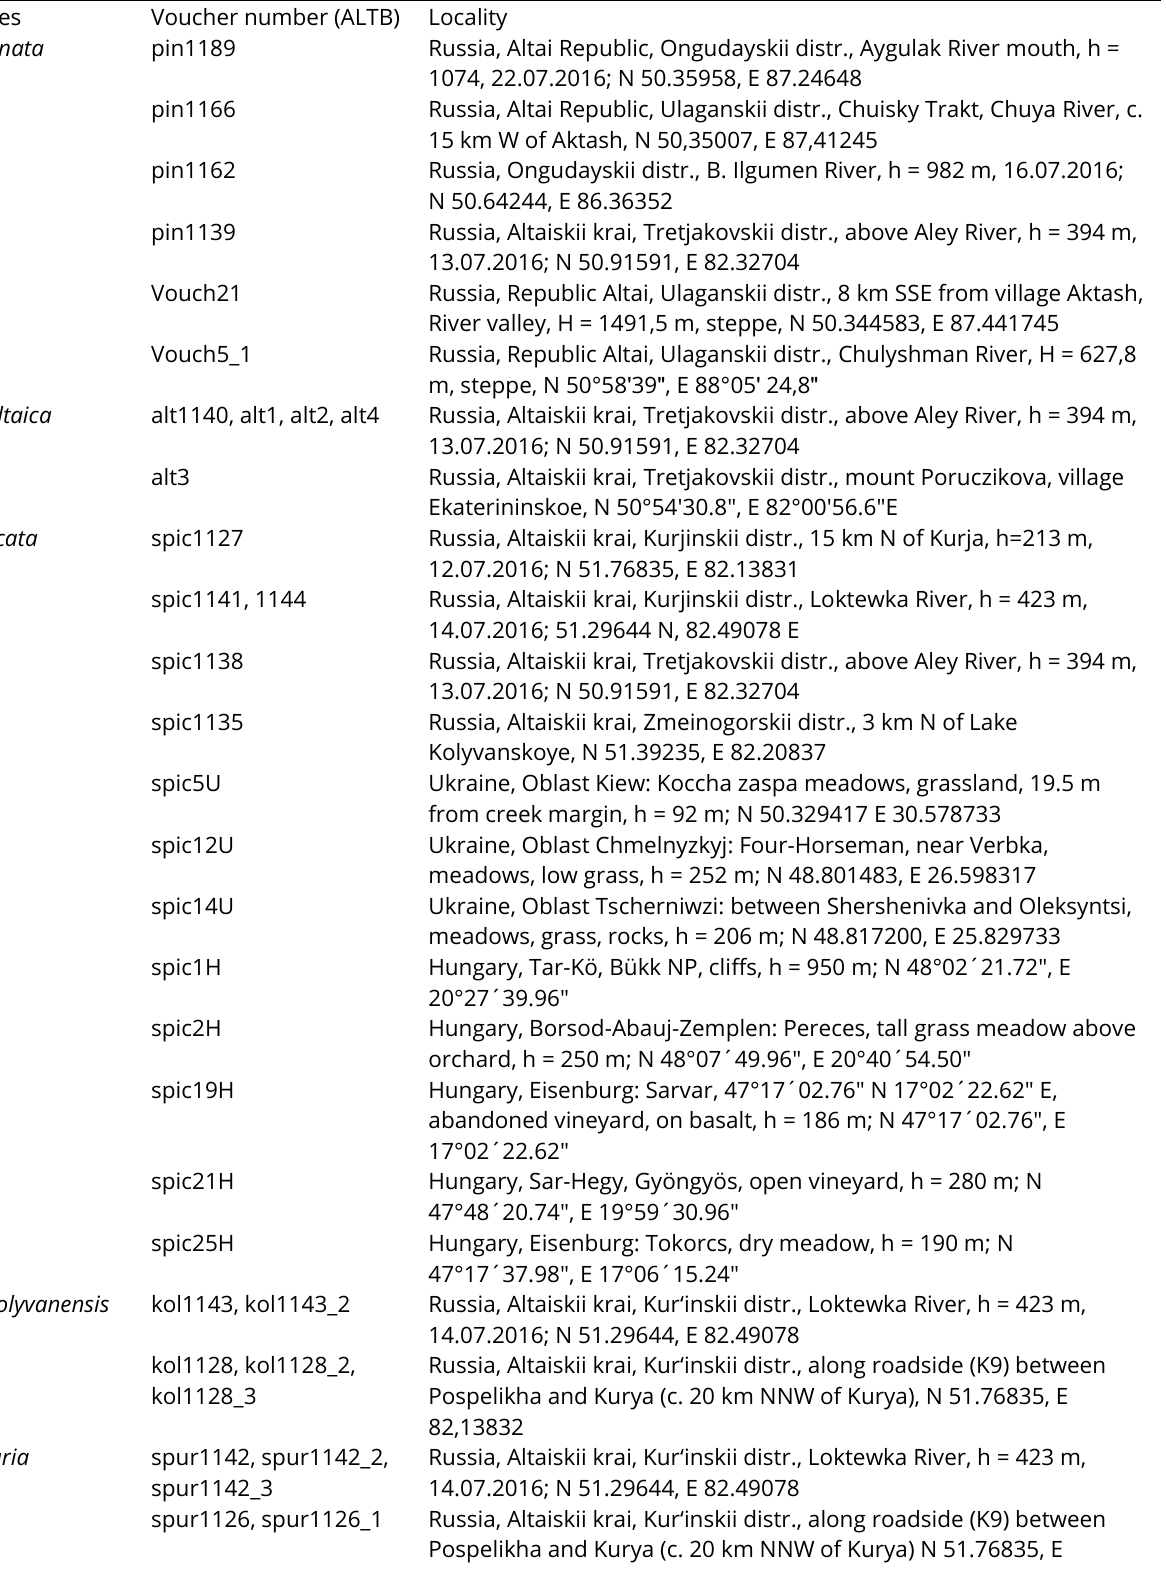
Table 1. Investigated taxa, voucher number and locality